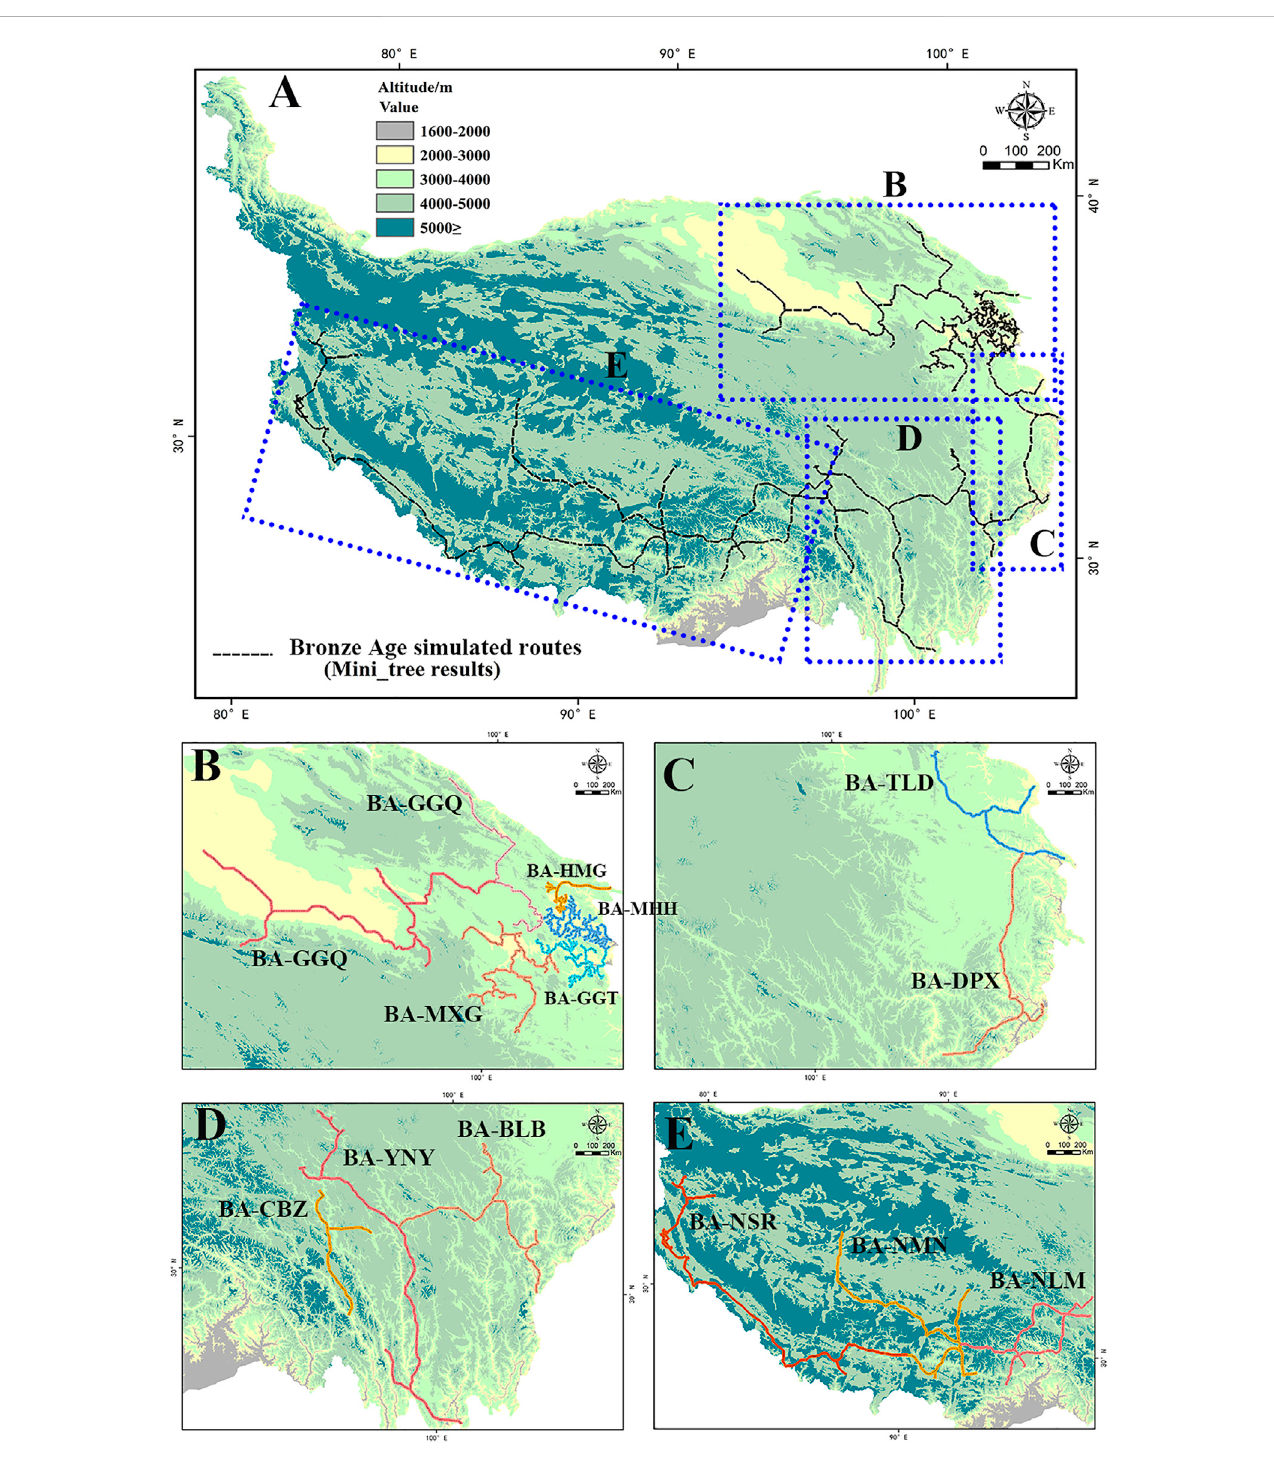
FIGURE 4 Simulated exchange routes for the Bronze age (BA). (A) overview of simulated routes and location of sub-areas; (B) northeast route area; (C) east route area; (D) southeast route area; (E) southwest route area. Individual route segments are labelled BA-XXX, with XXX referring to location